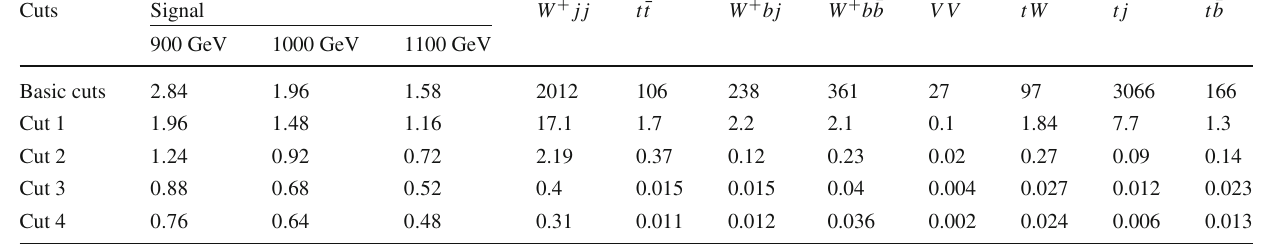
Table 1 The cut flow of the cross sections (in fb) for three typical signals and the relevant backgrounds at the 14 TeV LHC. Here we take the parameter as g ∗ = 0 . 2 Cuts Signal